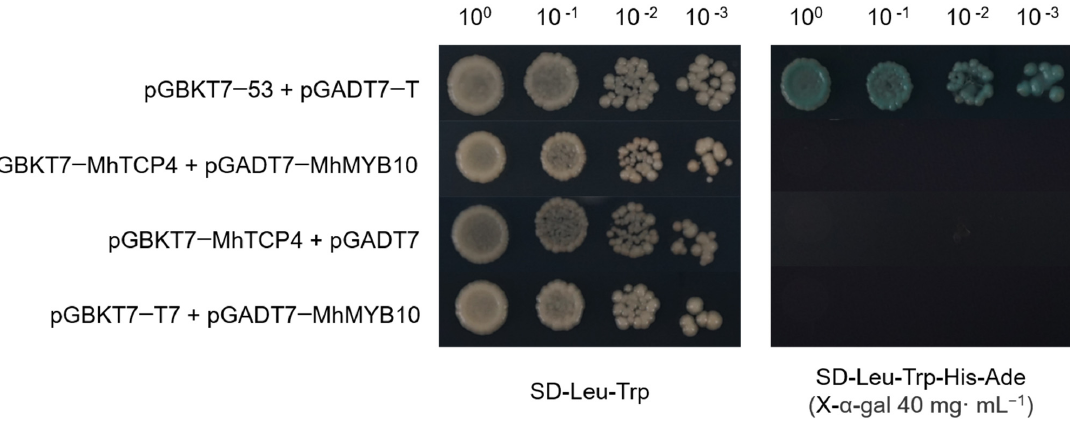
Figure 7. Yeast two-hybrid between MhTCP4 and MhMYB10. The CDS of MdTCP4 and MhMYB10 were fused to the pGBKT7 and pGADT7 vectors, respectively. The pGBKT7-53 + pGADT7-T vectors were used as positive control.